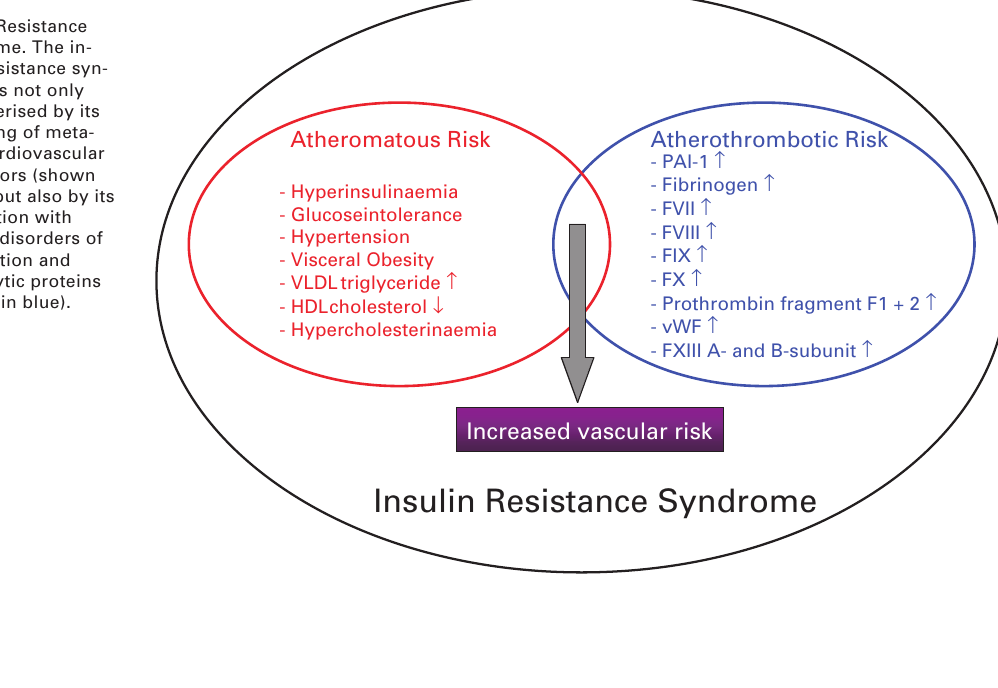
Insulin Resistance Syndrome. The in- sulin resistance syn- drome is not only characterised by its clustering of meta- bolic cardiovascular risk factors (shown in red) but also by its association with several disorders of coagulation and fibrinolytic proteins (shown in